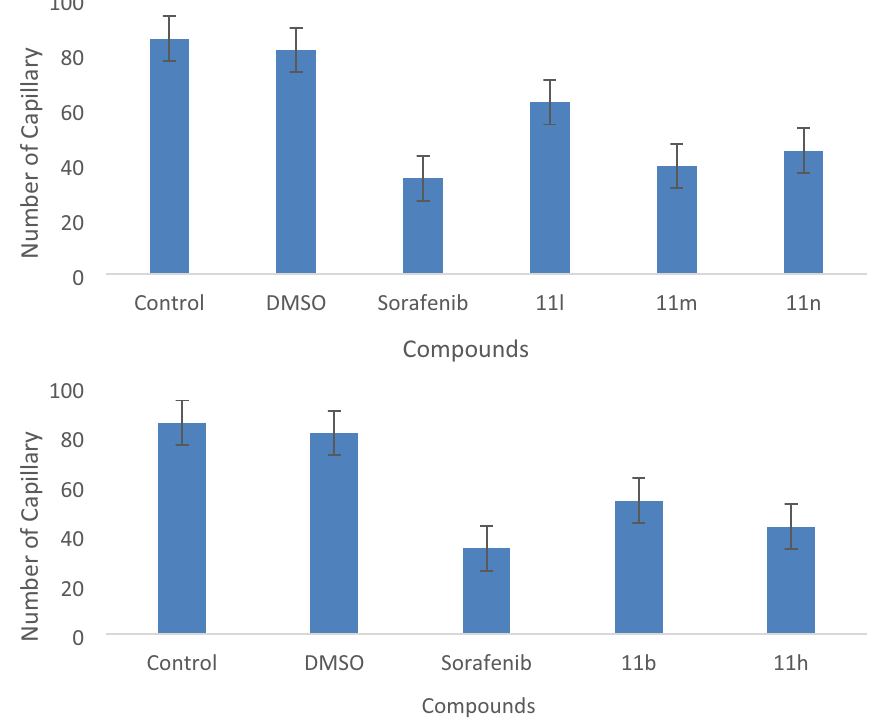
Figure 4. Average number of blood vessels treated with selected compounds at IC 50 concentration. CAM photographs of selected compounds. 11n , Sorafenib, and negative